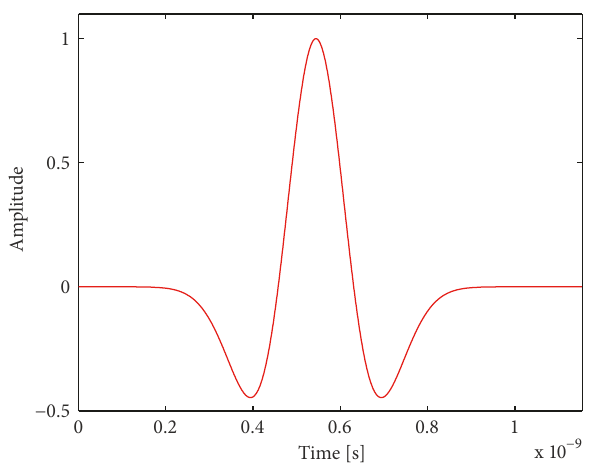
Figure 2: The Ricker pulse with 𝑓 = 6 GHz and 𝐴 =